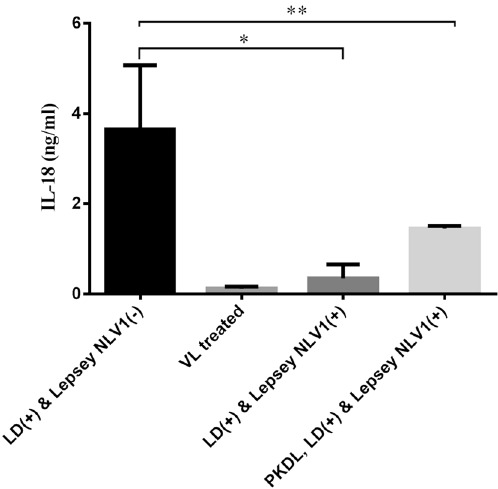
Figure 3. IL-18 in serum samples as found in quantitative IL-18 ELISA. Quantitative IL-18 ELISA was done as per manufacturer’s instructions. “(+)” and “(−)” signs represent the presence and absence of microbes- Leishmaina donovani (LD), Leptomonas seymouri narna like virus 1 (Lepsey NLV1). VL- Visceral Leishmania, PKDL-Post Kala-azar Dermal Leishmaniasis. ‘ p ’ values were calculated from actual IL-18 concentration in three replicates for each serum sample, by two tailed, unpaired t test at 95% level of significance. (* p = 0.002, ** p = 0.0126).